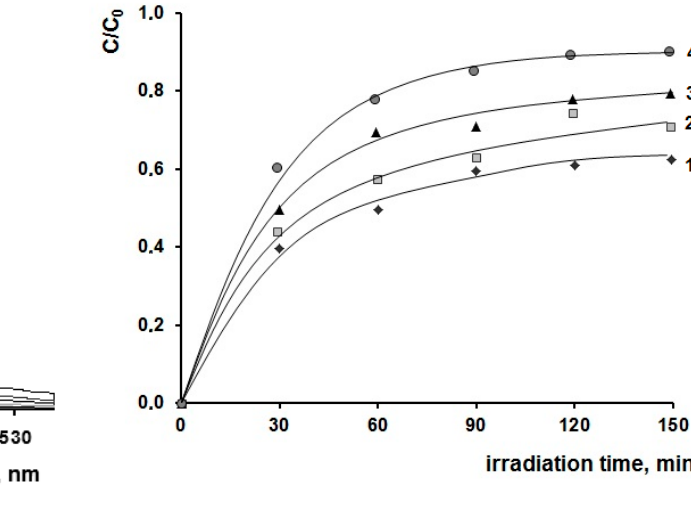
Figure 10. ( a ) The change of spectrum character of phenol aqueous solution under UV irradiation in the presence of nanocomposites (C = 19 mmol/L); ( b ) relative optical density dependence of phenol solution at 400 nm under UV irradiation in the presence of nanocomposites: curve 1—«empty» experiment, curve 2—BMA + Ag NPs, curve 3—HEMA + Ag NPs, curve 4—AN + Ag NPs.